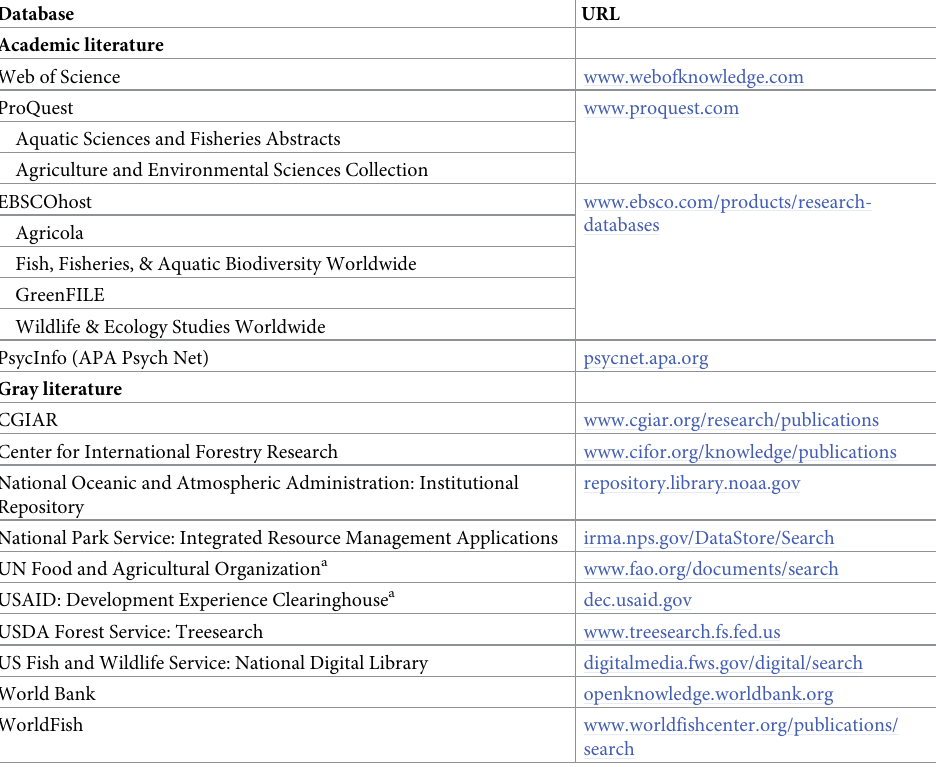
Table 1. Databases included in the systematic